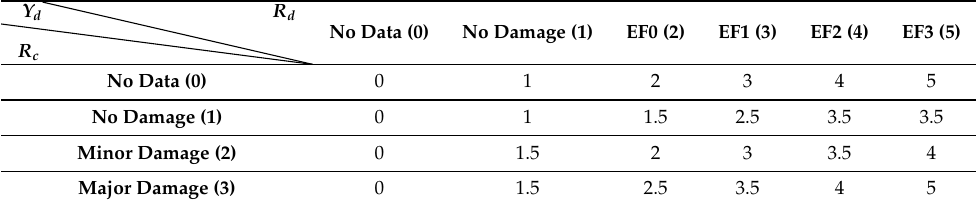
Table 2. Lookup table to determine Y d